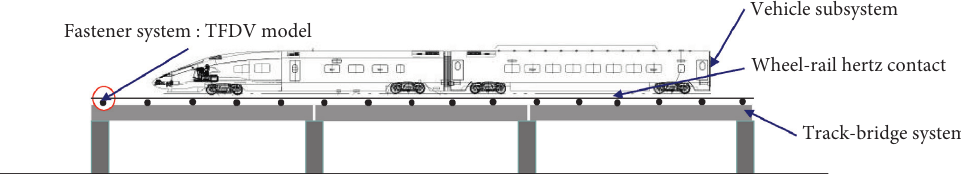
Figure 2: Subsystems of the vehicle-rail-viaduct system.